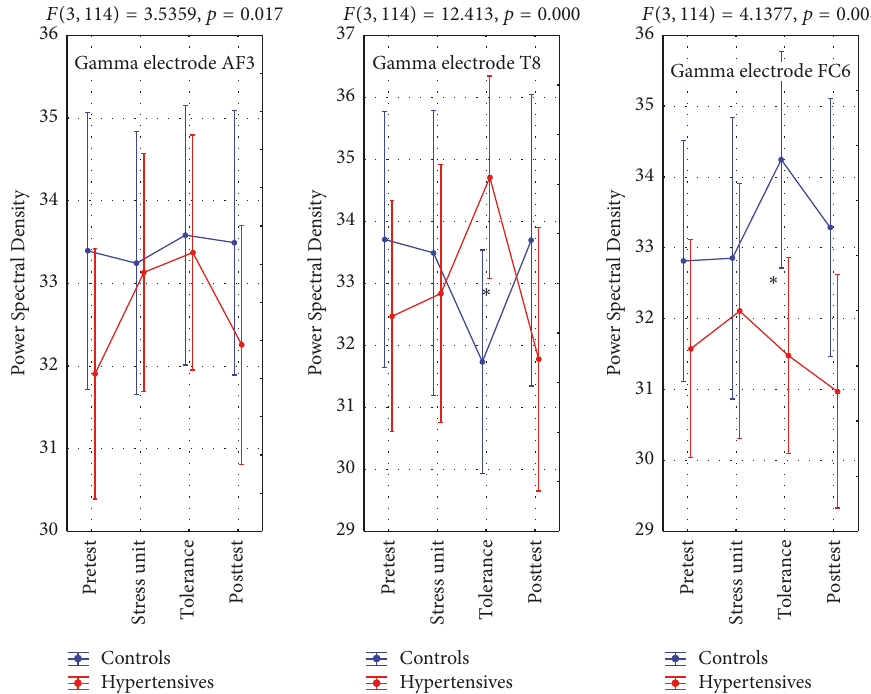
Figure 6: Gamma brain activity (GBA). ∗ refers to statistically significant differences.